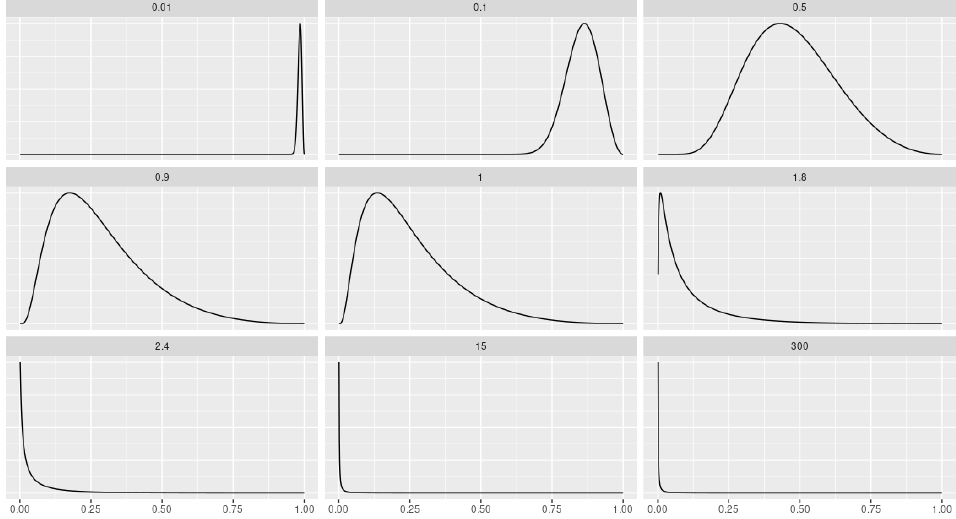
Figure 2. Density function of the AU distribution by varying the parameter α (displayed at the top of each chart). Whereas B ∼ BN ( 1 ) → B 2 ∼ χ 2 , then the AU model was generated from X = e − α | B | 3